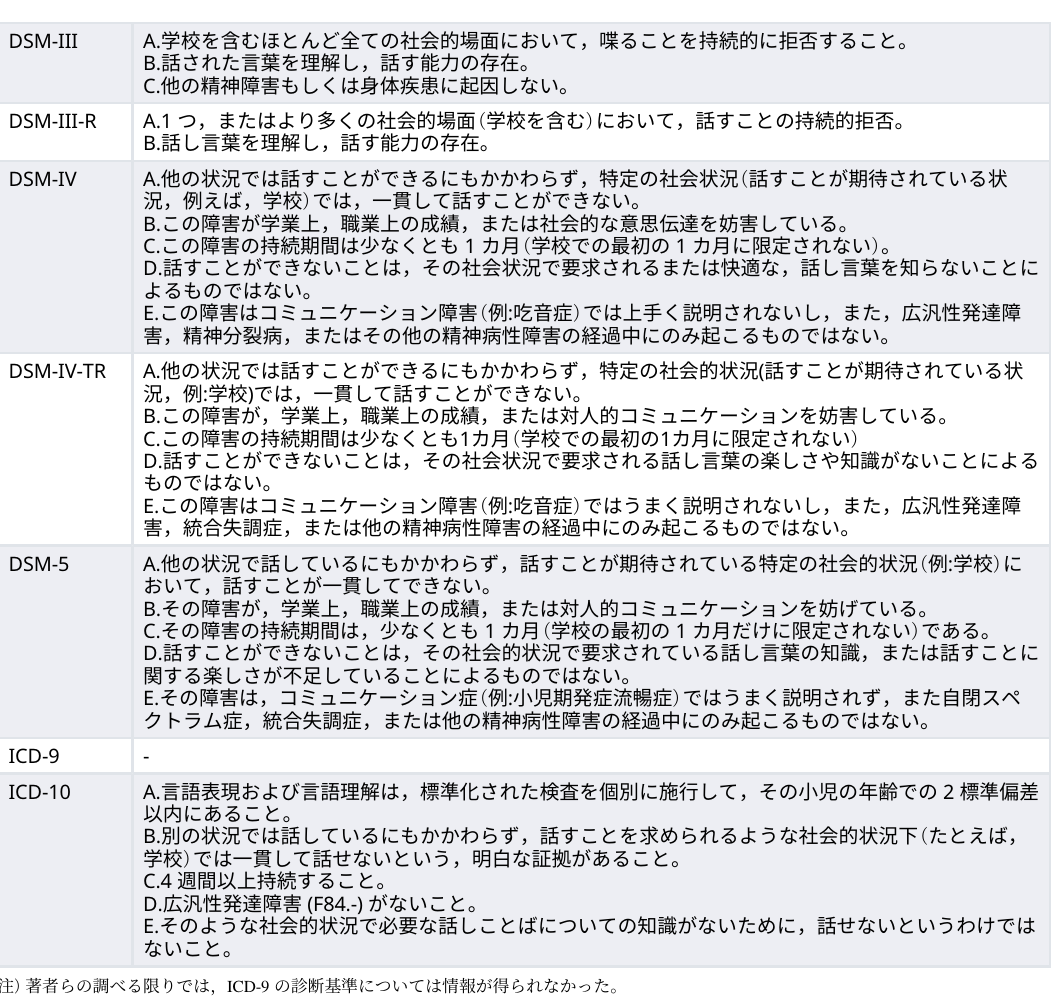
Table 1. 場 面 緘 黙 ( 選 択 性 緘 黙 ) の 診 断 基 準 .